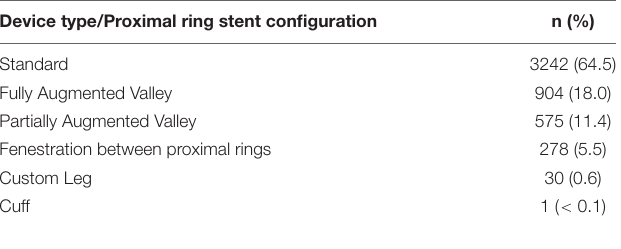
TABLE 4 | Device type/proximal ring stent